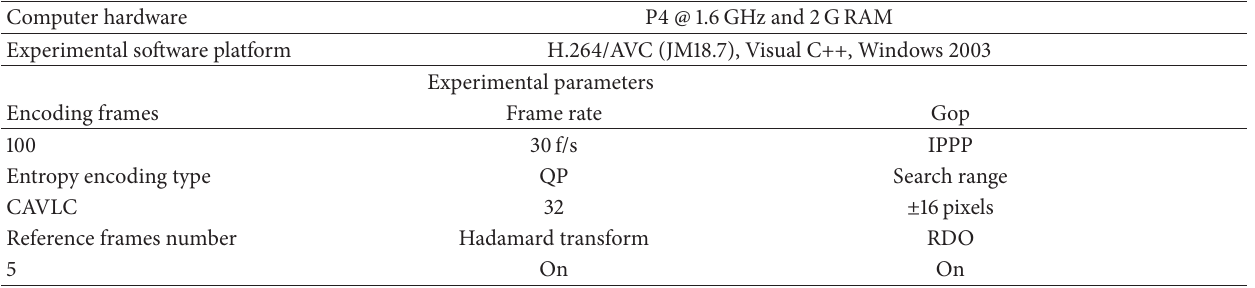
Table 5: Experimental environment.